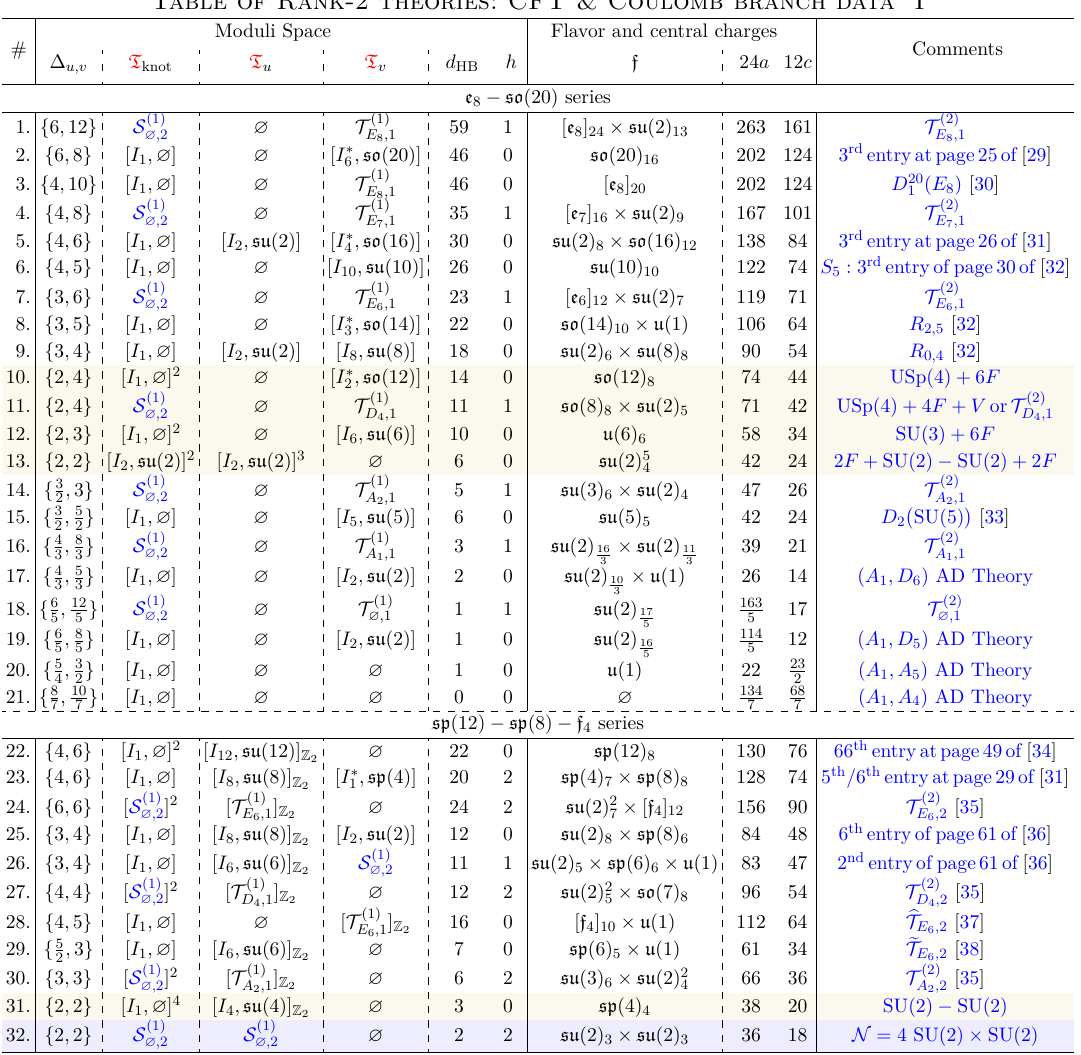
Table 1. First part of the list of rank-2 theories organized by series . Theories in each series are mutually connected by mass deformations. The second column lists the scaling dimension of the Coulomb Branch (CB) parameters. Columns 3, 4 and 5 instead list the rank-1 theories describing the massless states on the connected components of the CB singular locus, see table 4 for how to read these entries. The Z subscript indicates discrete gauging. Continuing, d indicates the ‘ HB quaternionic dimension of the Higgs Branch (HB) while h that of the Enhanced Coulomb Branch (ECB). Column 8 indicates the flavor symmetry of theory, along with the level, followed by the a and c central